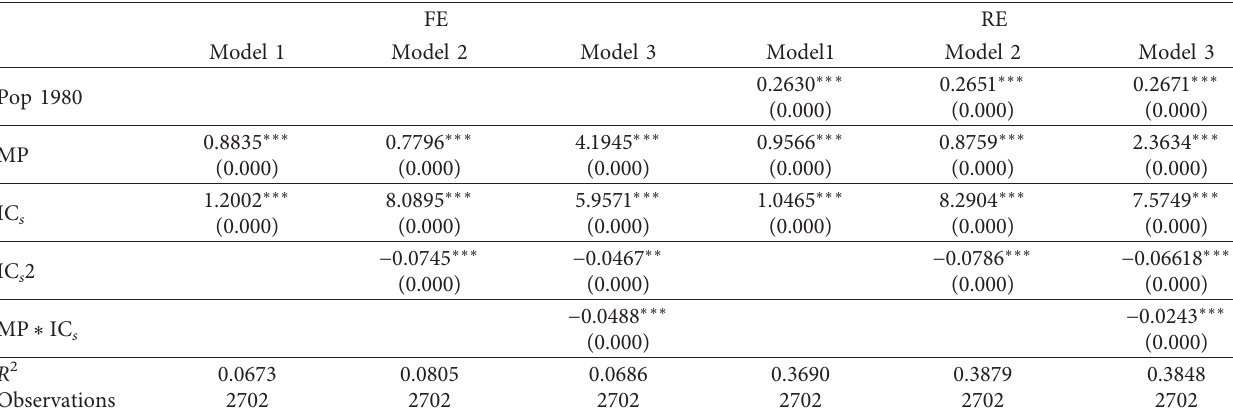
Table 5: Regression results of service share, 5-year periods.